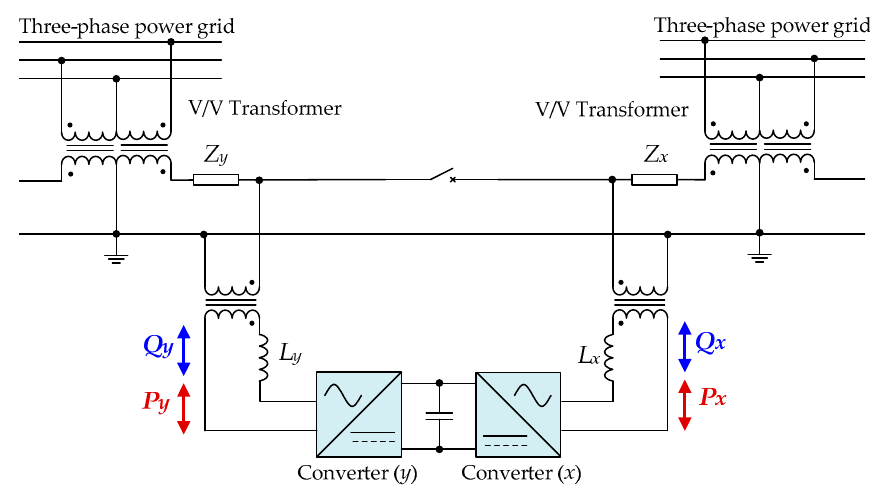
Table 3. Capabilities of the RPC operating as an interface converter between two substations.